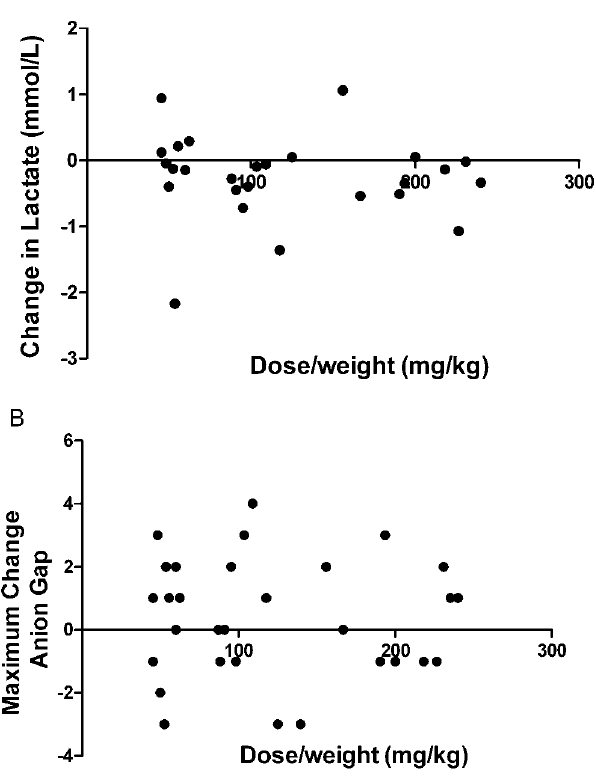
Figure 6. Effects of L-arginine hydrochloride infusion on venous blood lactate concentrations and anion gap. Figure 6A: Relationship between dose/weight (mg/kg) of L-arginine and change in venous blood lactate before and 4 hours after infusion (n=30; ns). Figure 6B: Relationship between dose/weight (mg/kg) of infused L-arginine and the maximal change in venous anion gap at any time during or in the two hours following infusion (n=30; ns).